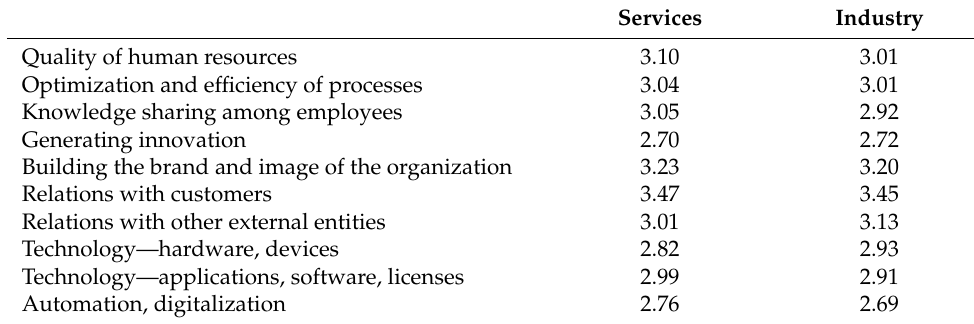
Table 5. Average assessment of current activities conducted in selected areas based on sector.